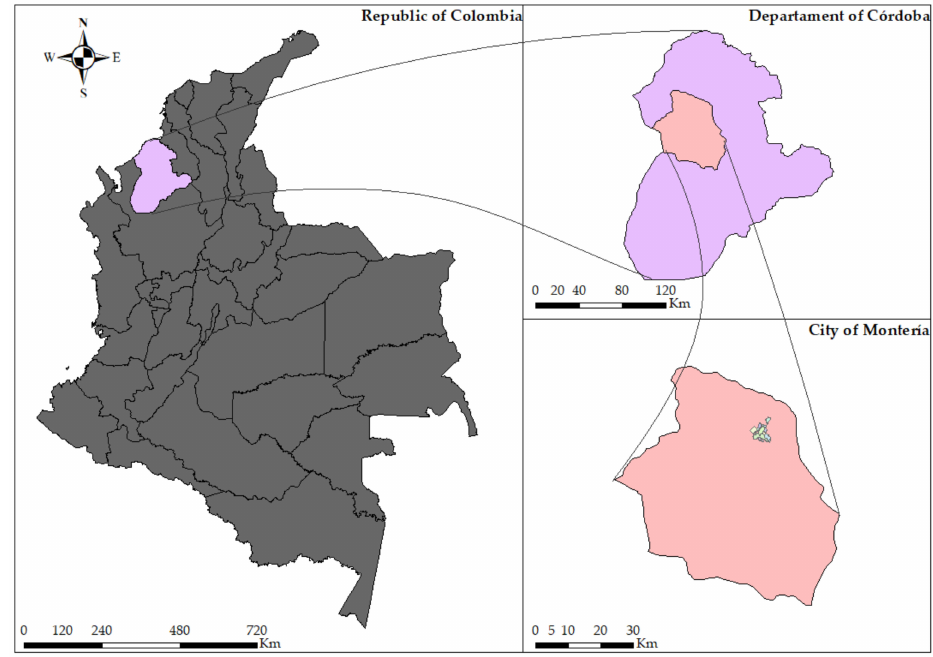
Figure 3. Geographic location of the municipality of Monter í